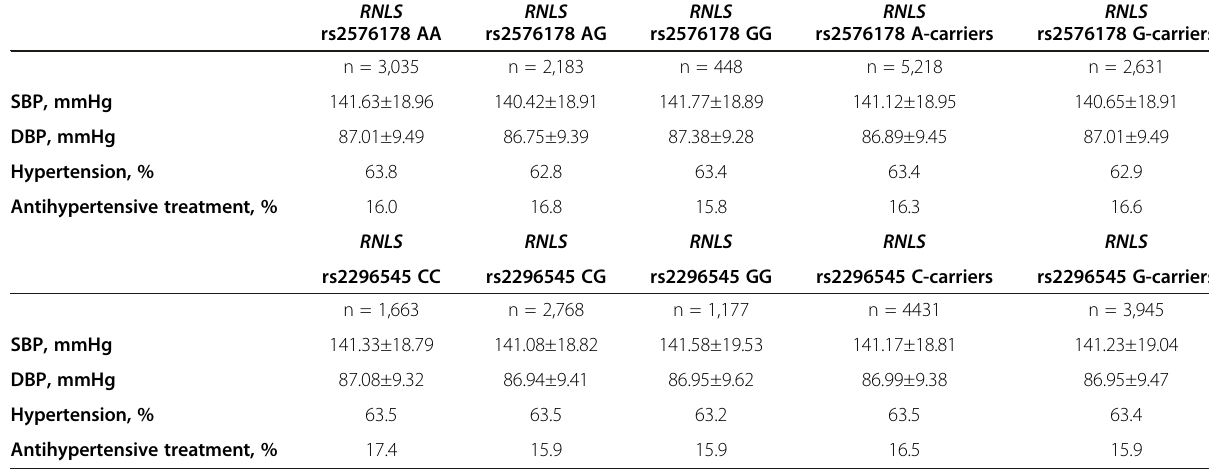
Table 2 Crude blood pressure values and hypertension prevalence according to genotypes in MDC-CVA